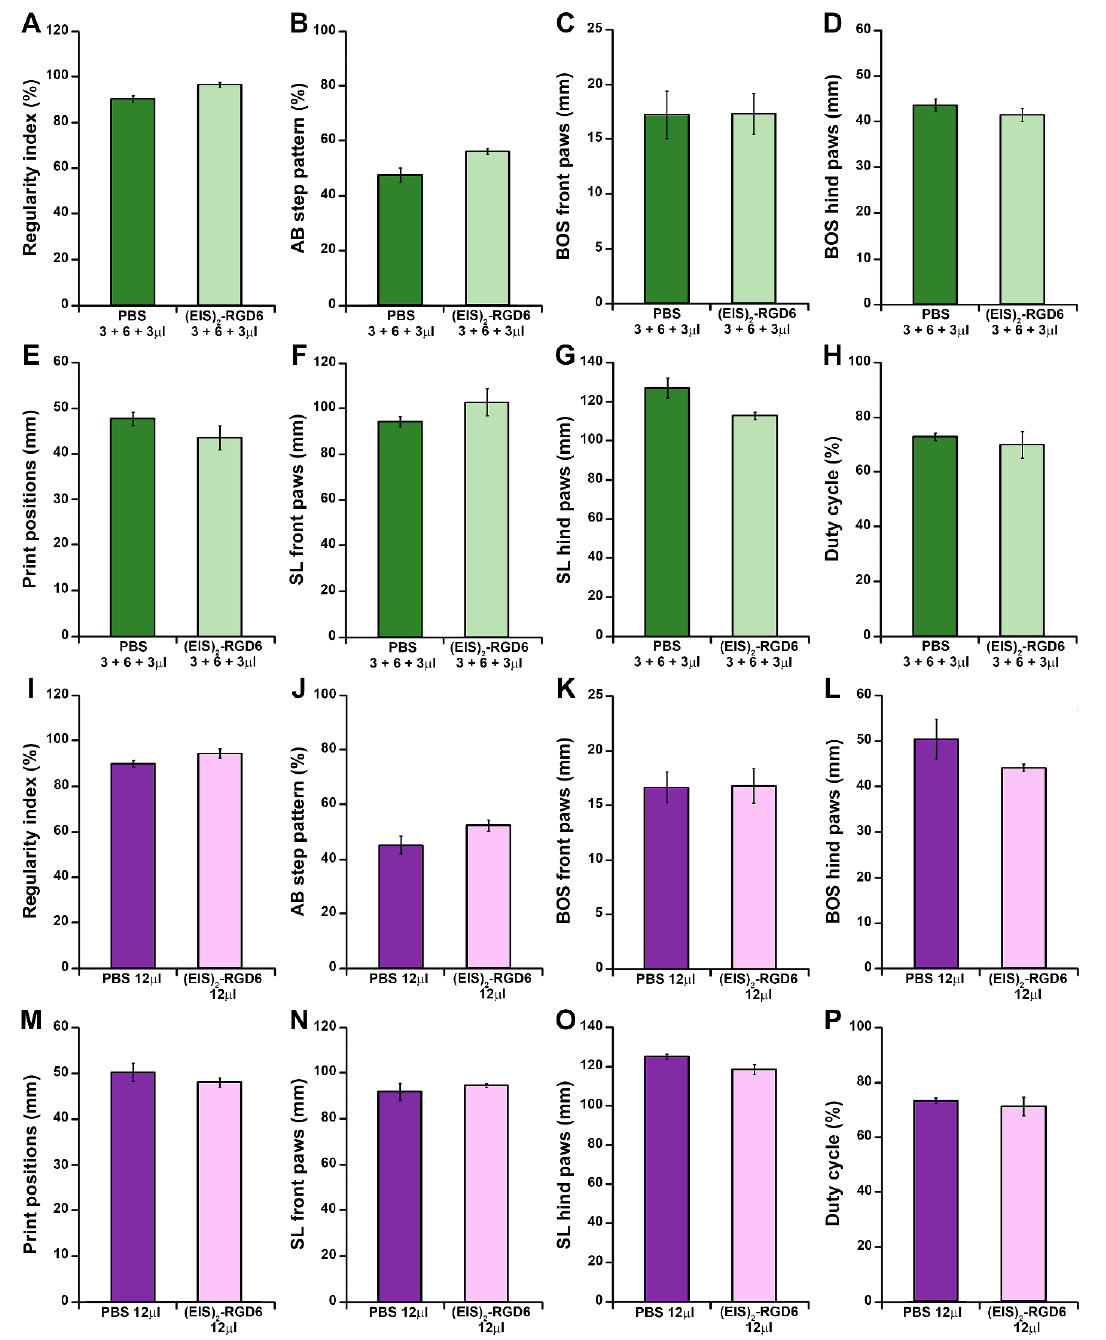
Figure 5. Determination of the injection system: Catwalk ® -based gait analysis III. Figure showing data obtained from the evaluation at 42 days post-injury of motor functional recovery using the Catwalk ® gait analysis system [PBS 3 + 6 + 3 µ L group vs. (EIS) 2 -RGD6 3 + 6 + 3 µ L group ( A – H ) and PBS 12 µ L group vs. (EIS) 2 -RGD6 12 µ L group ( I – P )] in the experimental set performed to